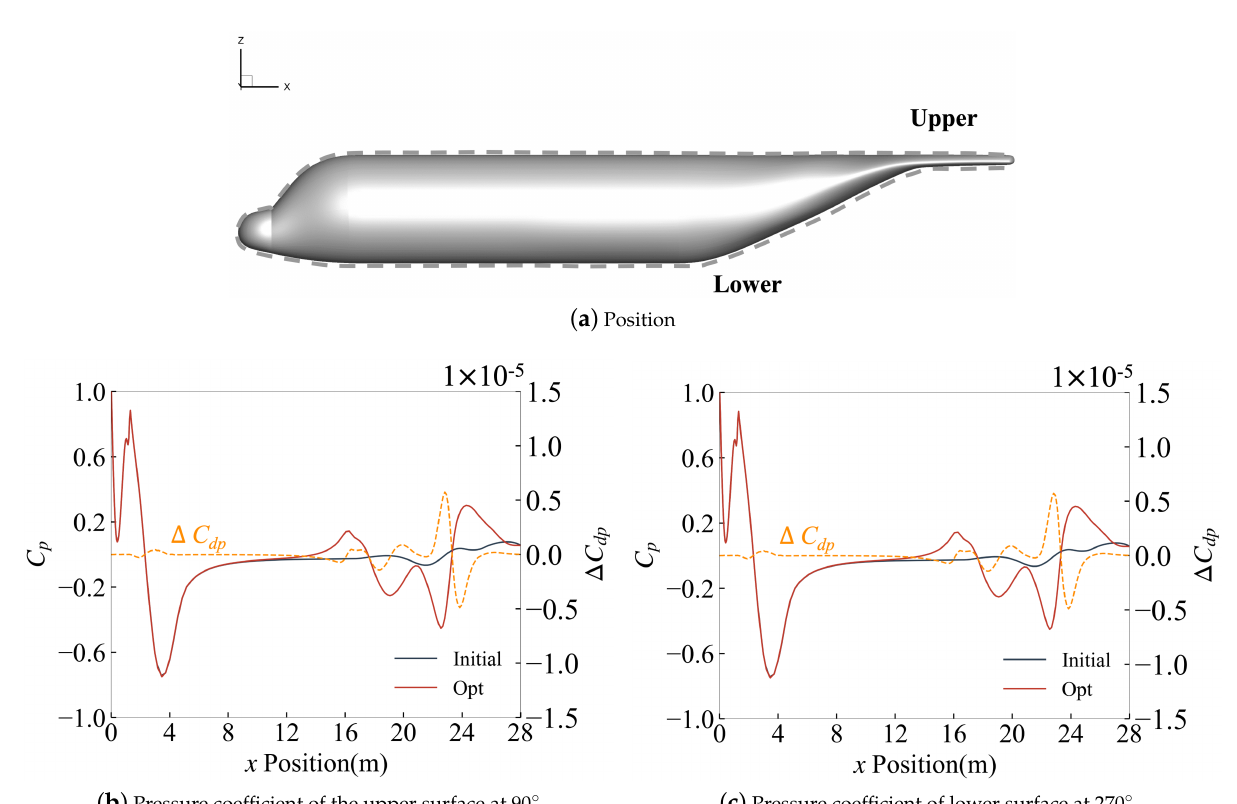
Figure 22. Comparison of pressure coefficient on upper and lower